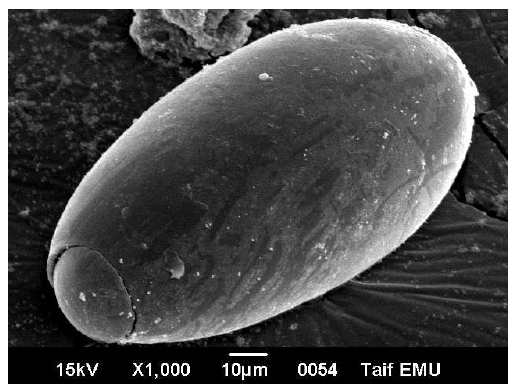
Figure 4. Fasciola egg treated in vitro with the drug only. Notice the alterations on the egg surface due to drug administration.